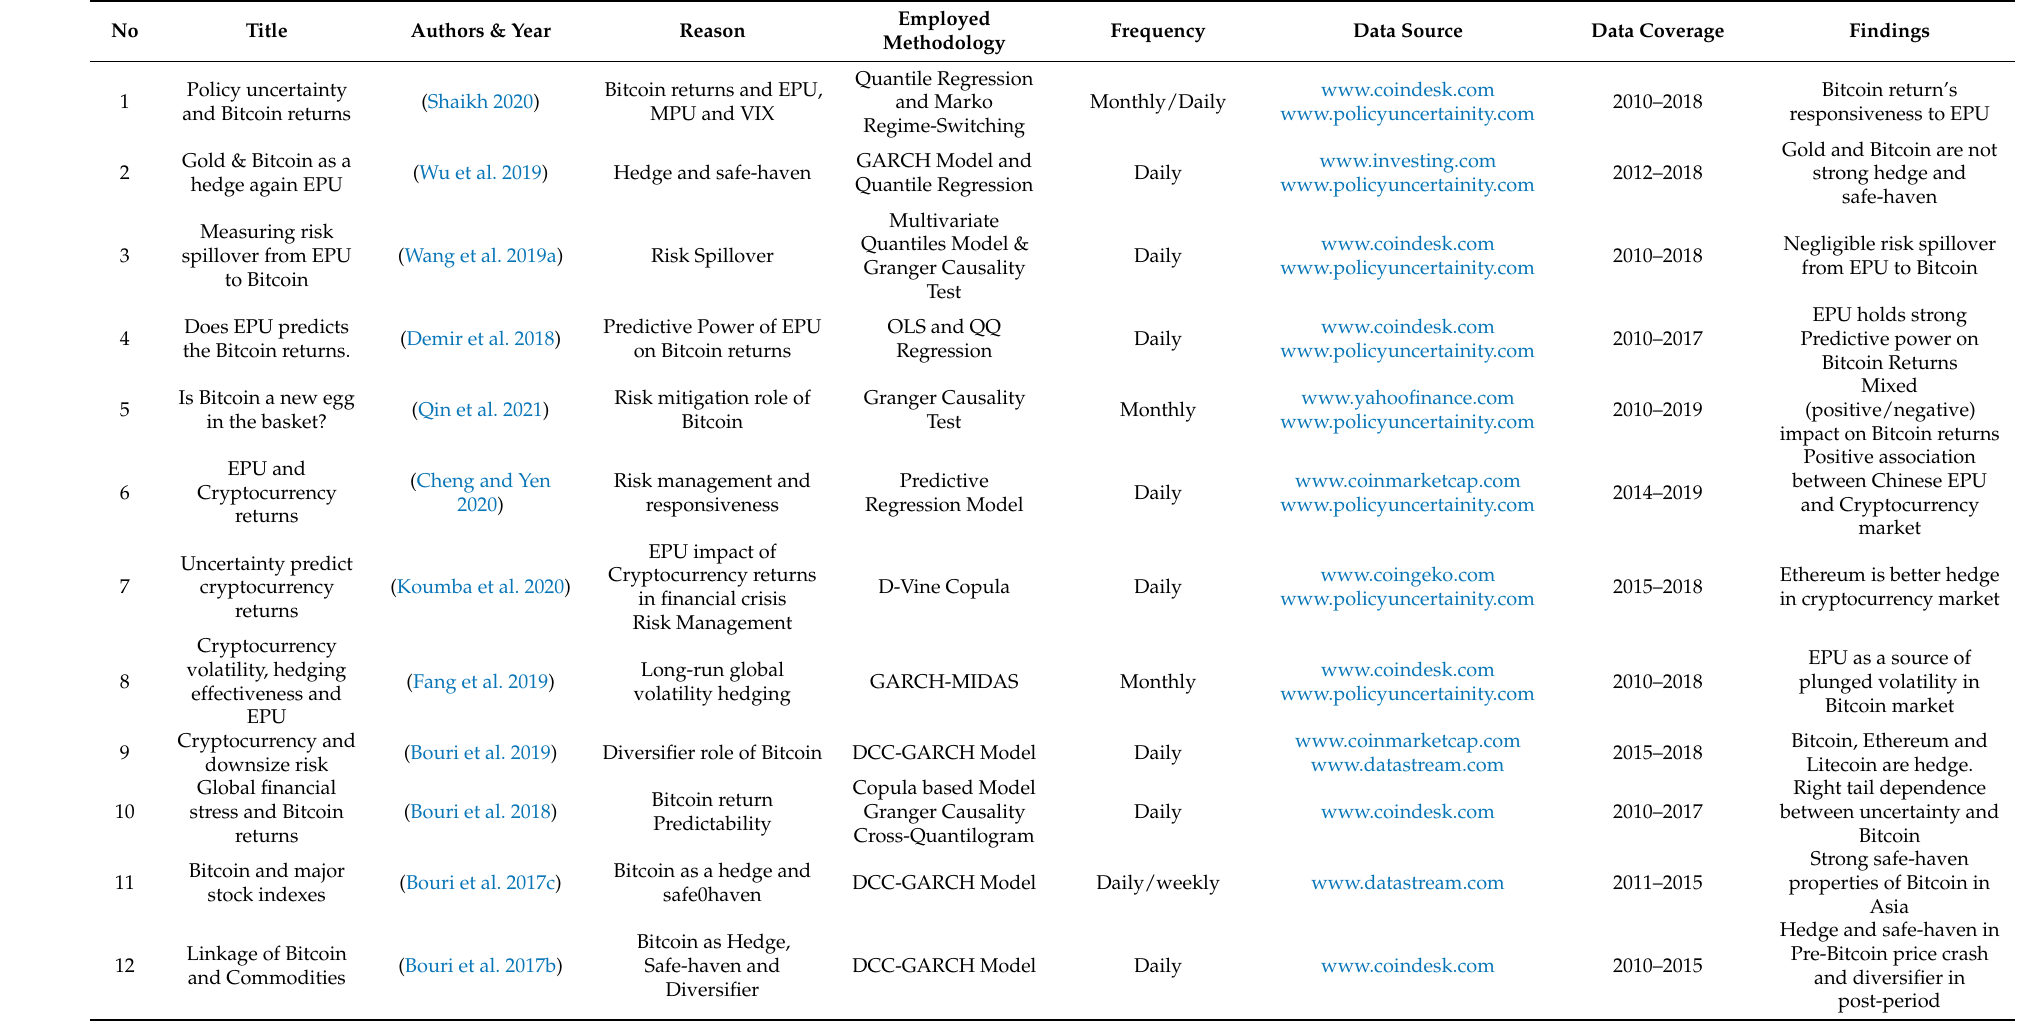
Table 2. Key Characteristics of Included